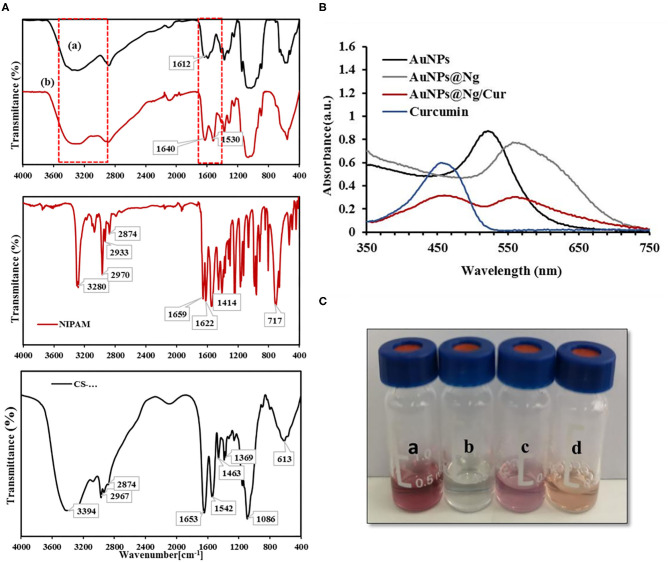
FT-IR spectra of chitosan (a), thiolated chitosan (b), pure NIPAM and Ng. (A) UV-VIS spectrum of AuNP, Curcumin, AuNP@Ng, and AuNP@Ng/Cur (B). Physical appearance of AuNP (a), Ng (b), AuNP@Ng (c), and AuNP@Ng/Cur (d) (C).